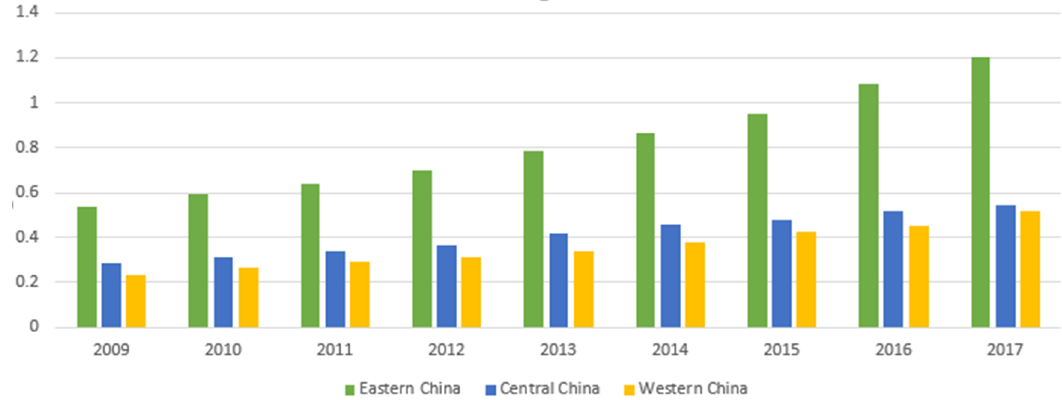
Figure 1. The carbon productivity data of China’s eastern, central, and western regions for 2009 to 2017.